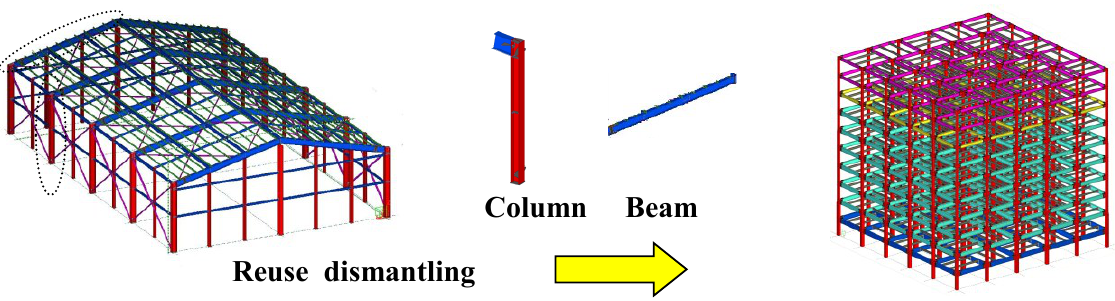
Figure 2. Steel structural members for reuse.